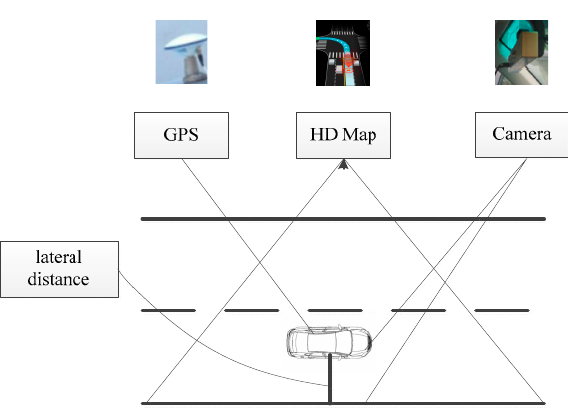
Figure 3. Lateral distance from monocular vision and GPS via HD map.